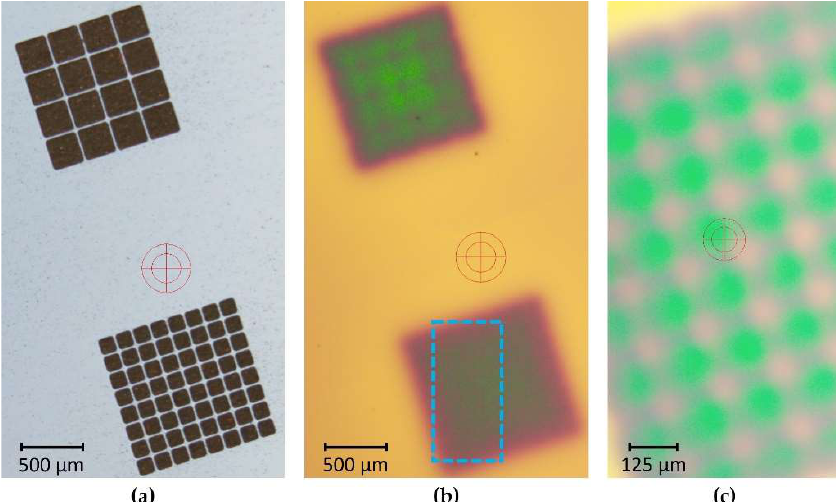
Figure 4. ( a ) Optical image of NdFeB microstructures embedded in a silicon substrate. ( b ) The same structures imaged with a magneto-optical sensor based on the Faraday effect. The contrast corresponds to the strength of the out-of-plane component of the magnetic field. ( c ) Magneto-optical image of the ROI marked by a dashed frame in ( b ), acquired at higher magnification with a different lens.